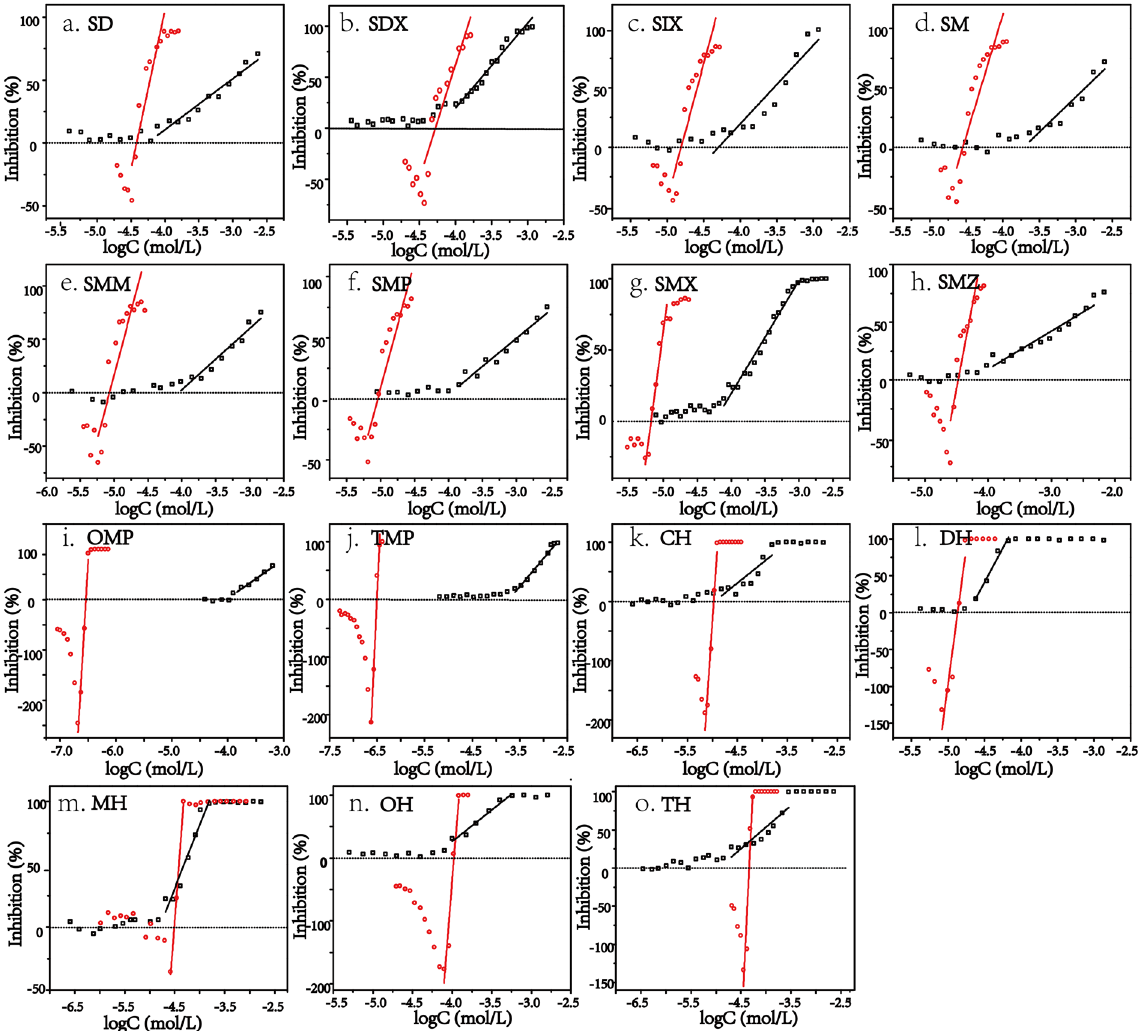
Figure 1. Dose-effect curves for the acute (black) and chronic (red) toxicity of the individual